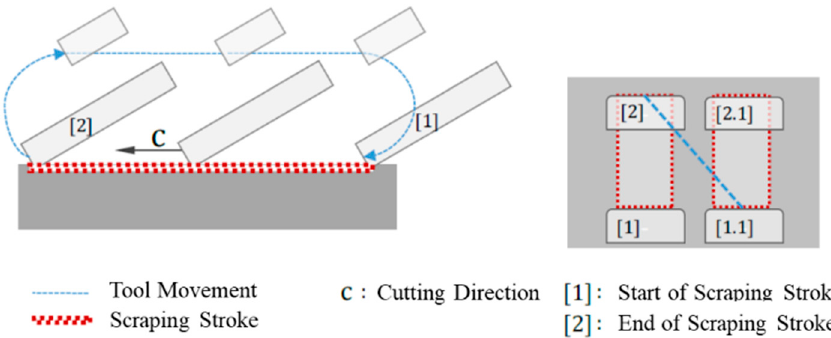
Figure 1. Tool movement during hand scraping following Schmid [9].